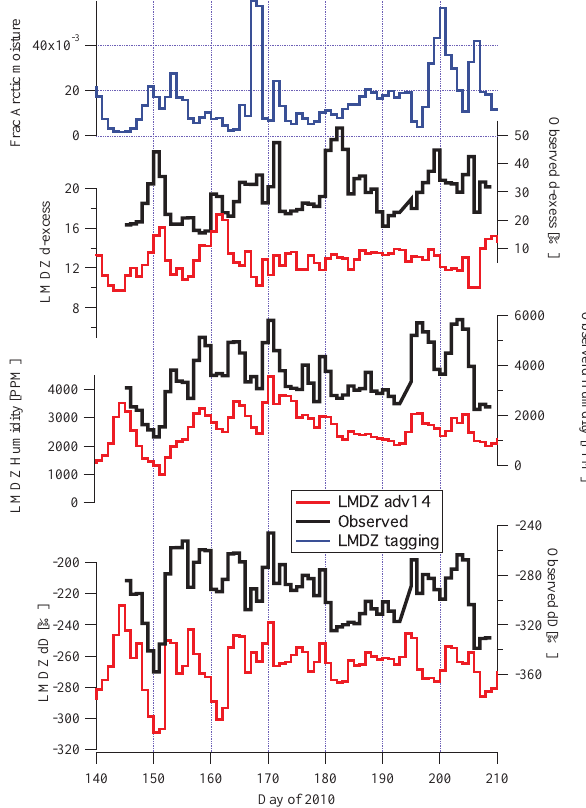
Fig. 6. Comparison between daily mean GCM model outputs from LMDZiso with water tagging and observed daily mean humidity and isotopic composition from 1m above the snow surface by the LGR